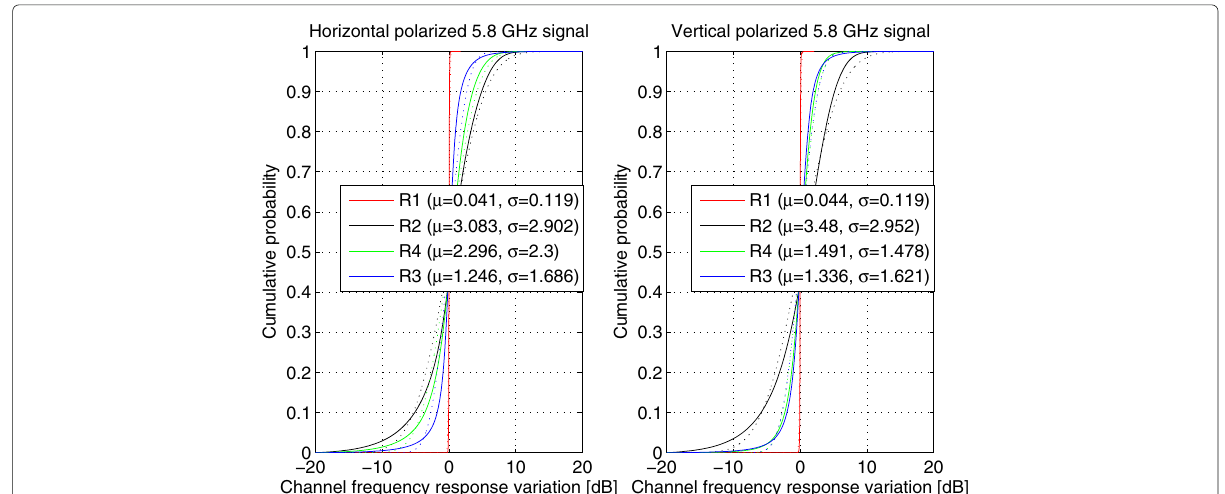
Fig. 15 Cumulative distribution function of channel frequency response variation of 5.8GHz center frequency for both horizontal and vertical co-polarization. The curve colored in red, black, blue, and green represent the calculated channel frequency response variation for the first to the fourth routes, respectively. The colored dotted lines represent the normal distribution of the corresponding measured channel frequency response variation